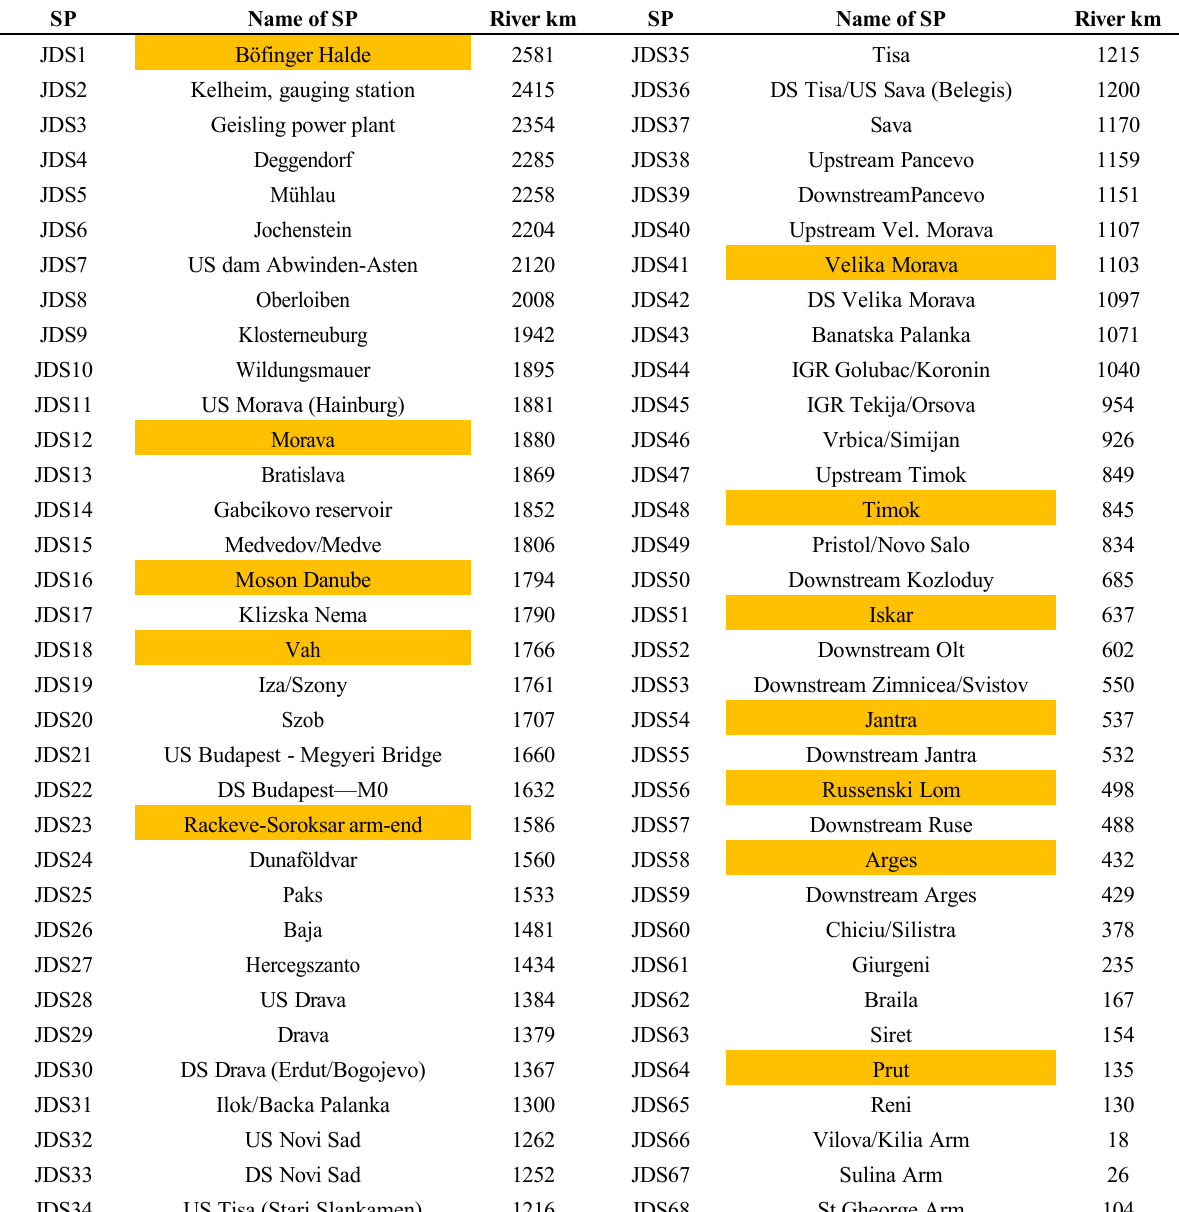
Table 1. List of the JDS3 sampling points (SP), the orange highlighted sampling points were only collected